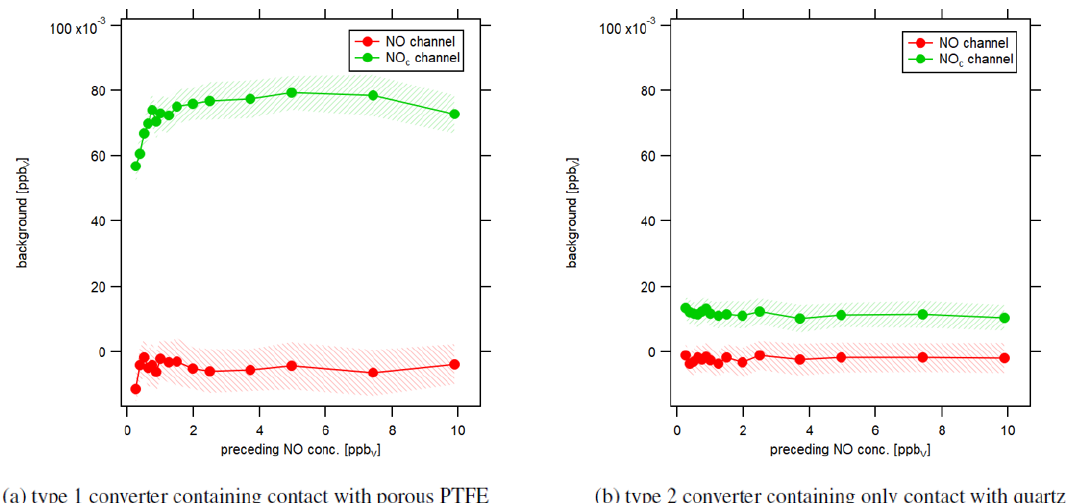
Figure 8. Instrumental background in response to different preceding NO concentrations under dry conditions. Each data point shows the level of the signal of the first 5min of instrumental background measurements after NO